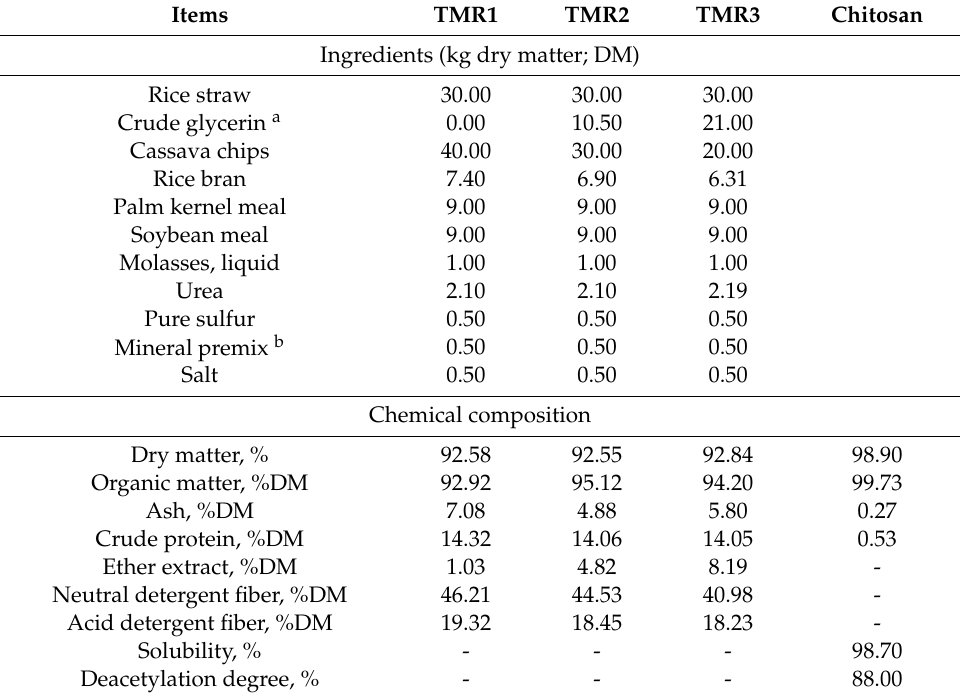
Table 1. Ingredients and chemical composition used in the total mixed ration